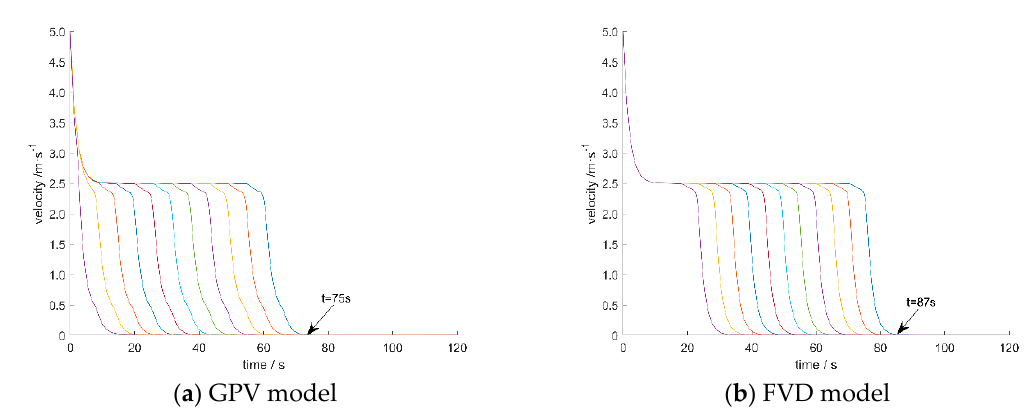
Figure 8. Comparison of velocity during the braking process between the two models.